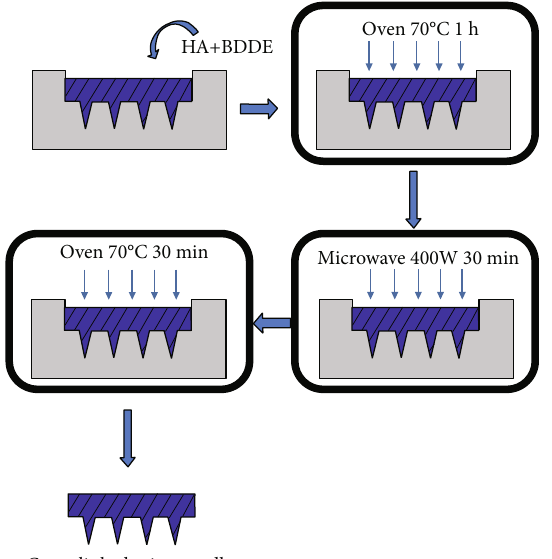
Figure 1: Preparation process of microwave crosslinking method of crosslinked hydrogels. Pour the prepared solution into the mold fi rst (a) and oven drying (b), then microwave drying (c), and fi nally back to oven drying (d).